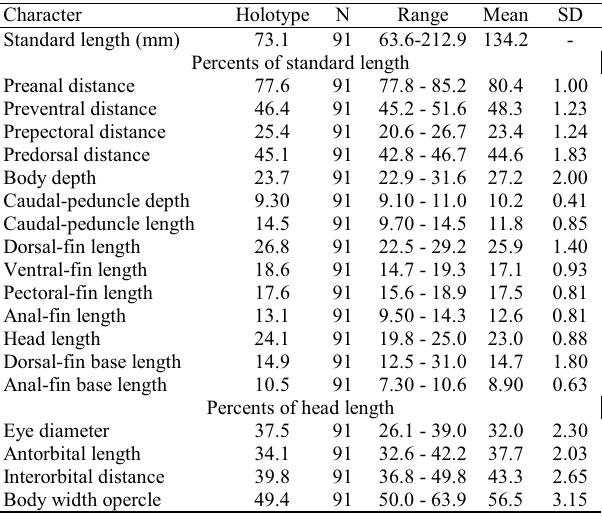
Table 1. Morphometrics of Laemolyta fernandezi .